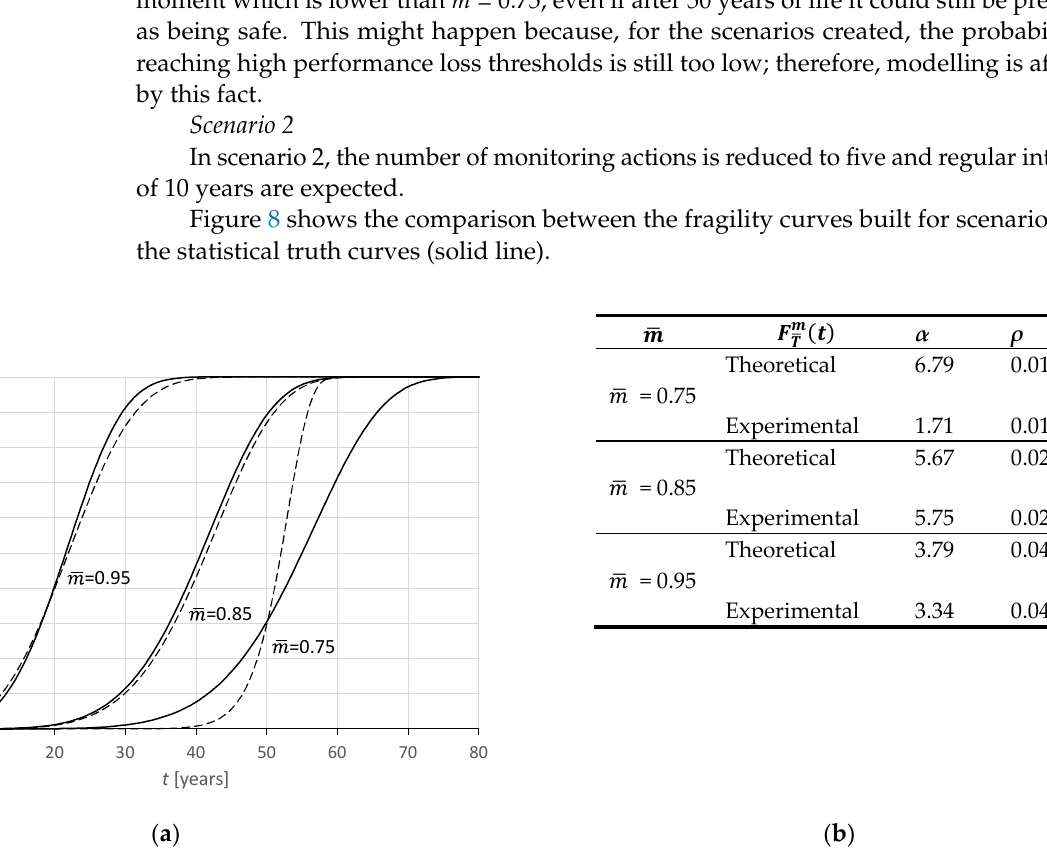
Figure 8. Scenario 2: ( a ) Comparison between experimental curves obtained for scenario 2 and the fragility curves defined as “statistical truth”. ( b ) Comparison of the parameters of the theoretical and experimental distributions.